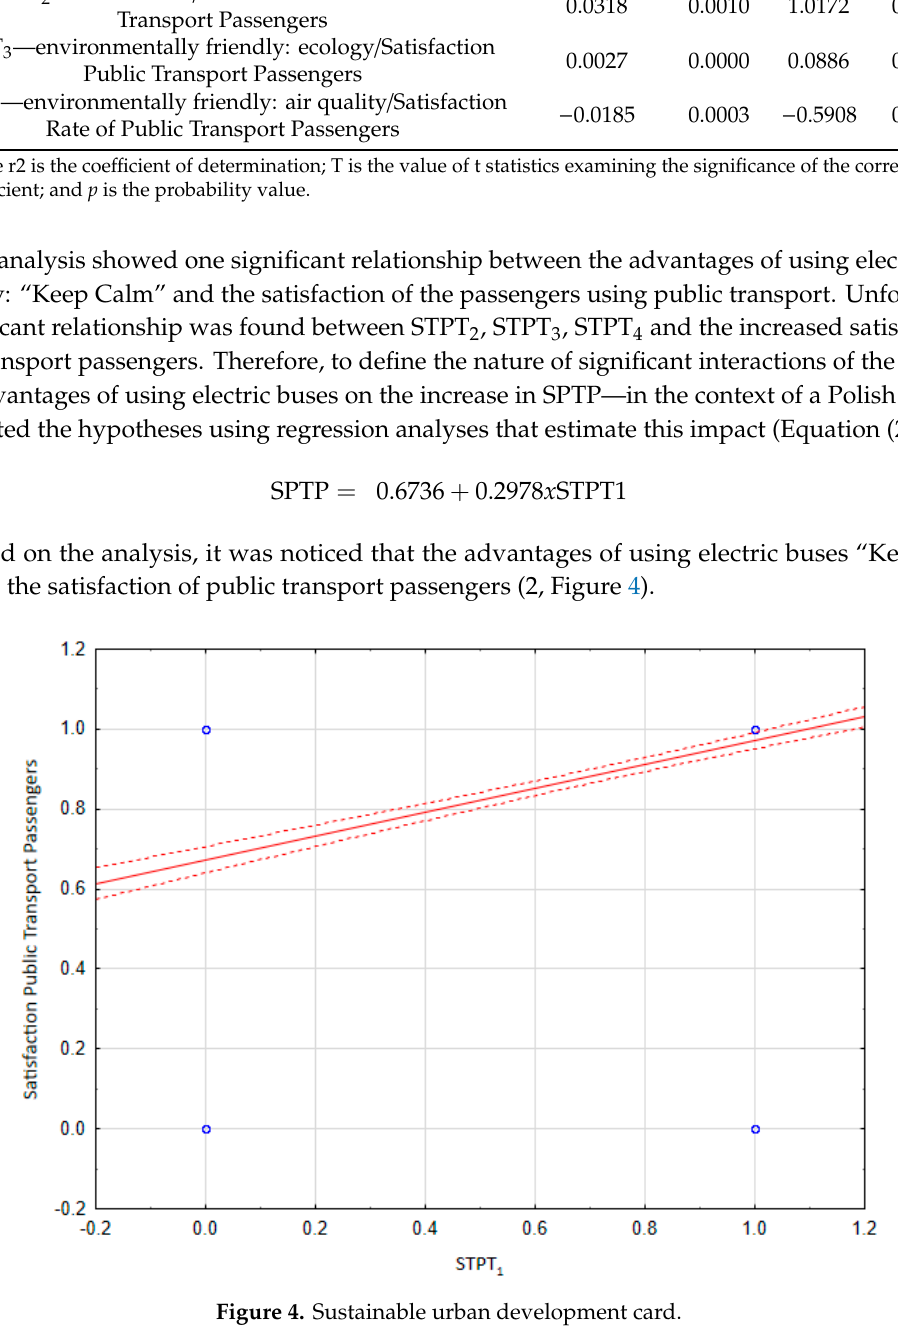
Table 4. Correlation analysis.